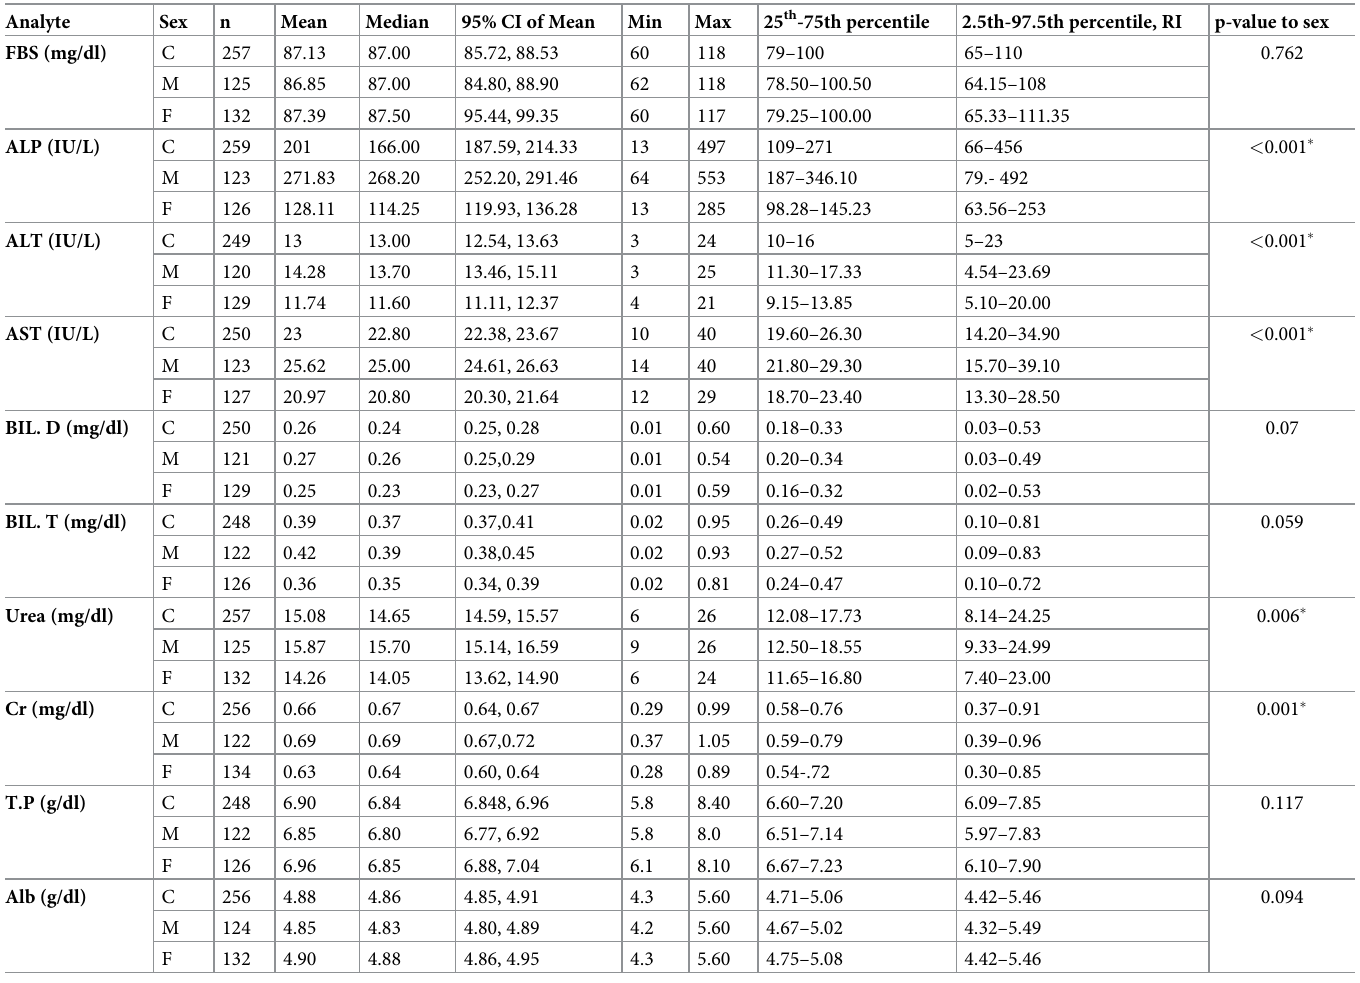
Table 2. The RIs of clinical chemistry parameters for Adolescents in Mekelle, Tigray Regional State, Ethiopia,